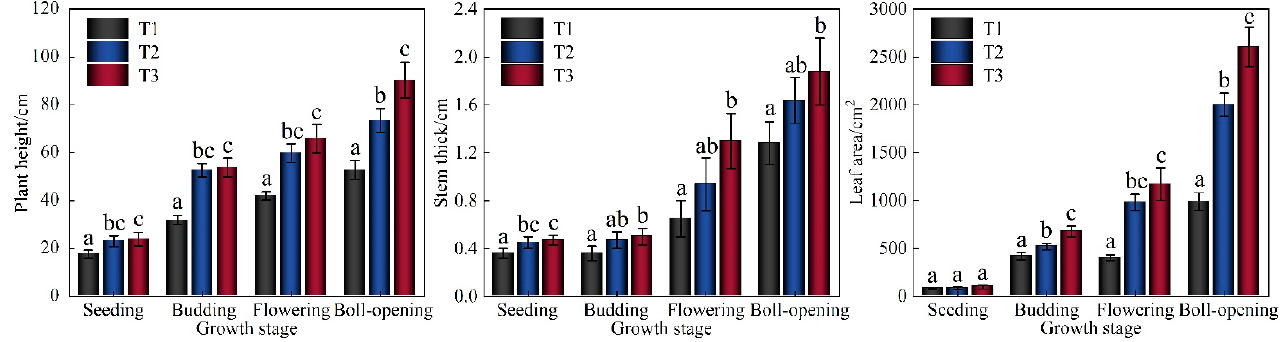
Figure 6. Dynamic changes in cotton plant height, stem thickness, and leaf area throughout the whole growth period.